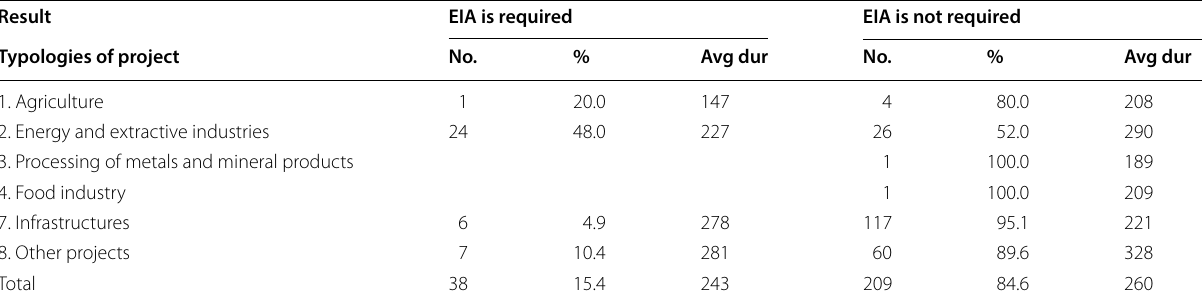
Table 12 Screening results and average duration Result EIA is required